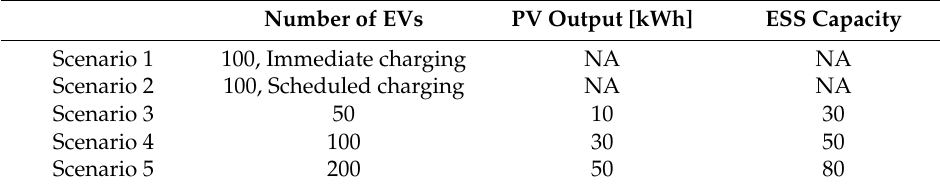
Table 2. Overview of simulation scenarios; NA: not available.